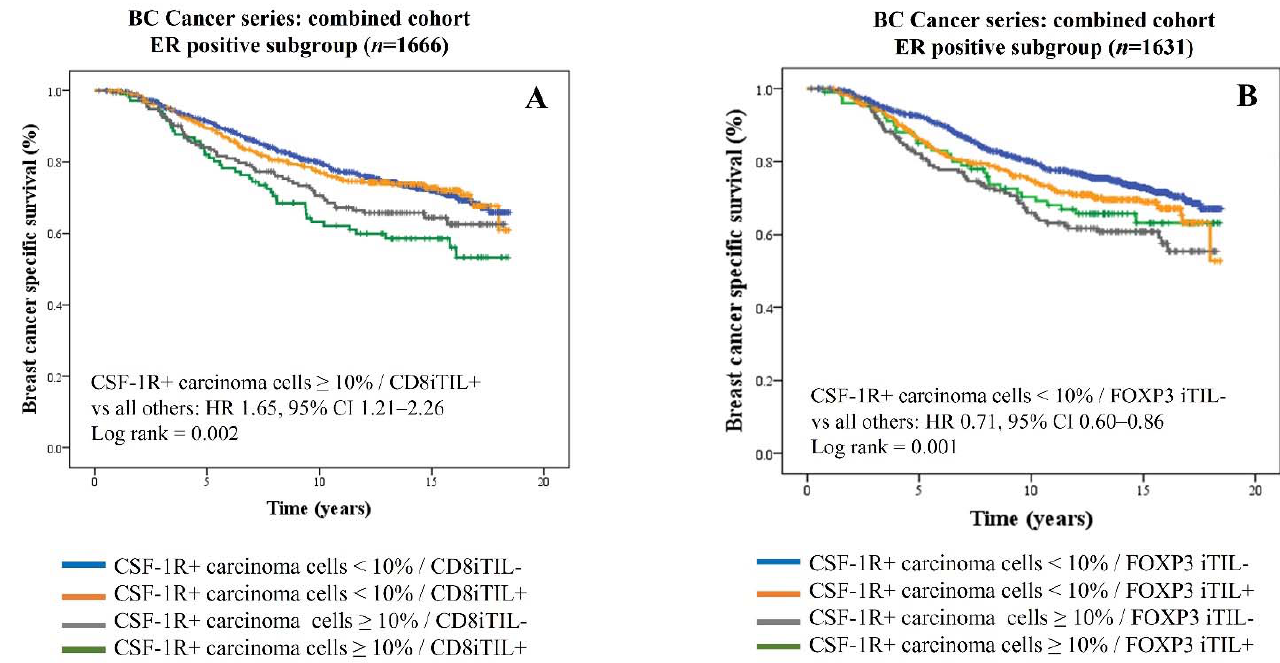
Figure 4. Kaplan–Meier survival curves for breast cancer-specific survival in ER-positive cases in the full BC Cancer cohort stratified by CSF-1R expression on carcinoma cells and intraepithelial tumor-infiltrating lymphocytes (iTILs) expressing CD8 ( A ) or FOXP3 ( B ).